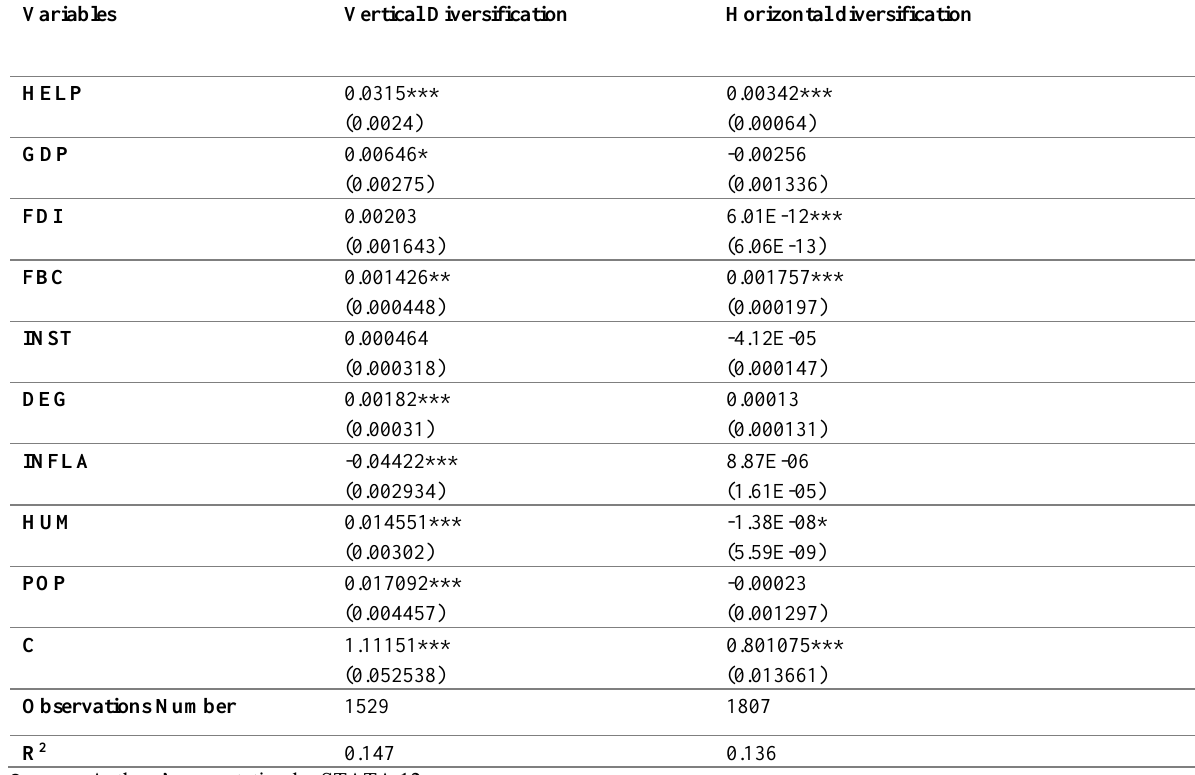
Table 3: Regression results for all